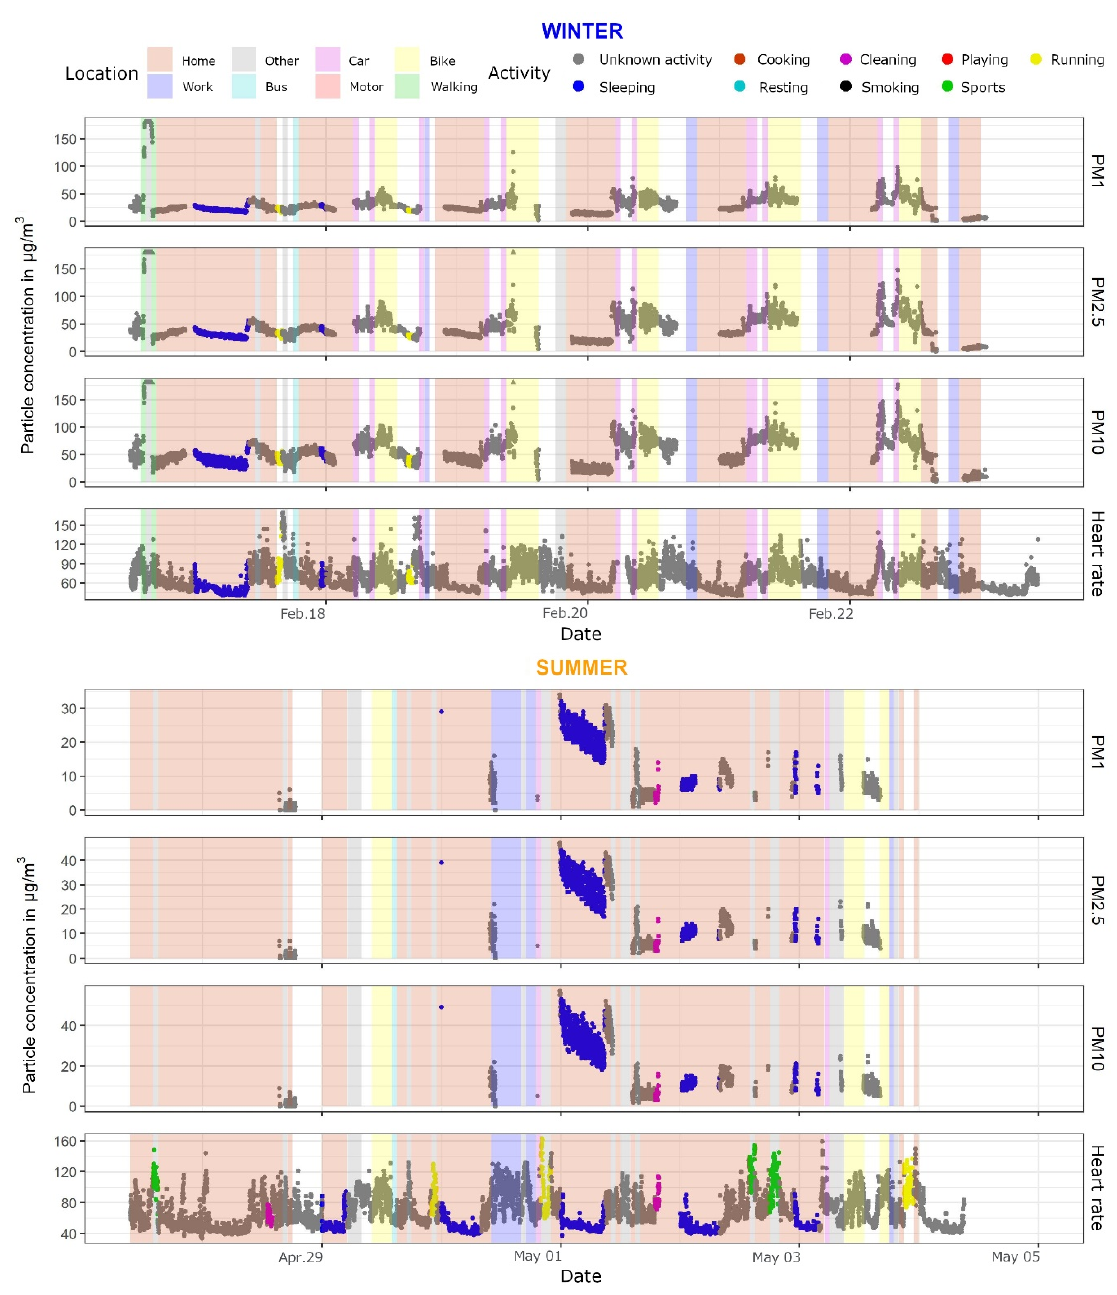
Figure 5. Three size classes of PM and heart rate values for both seasons with each point colored according to the associated activity and each ribbon representing a location or means of transport for that time period; data from PPM, SAT, and TAD.